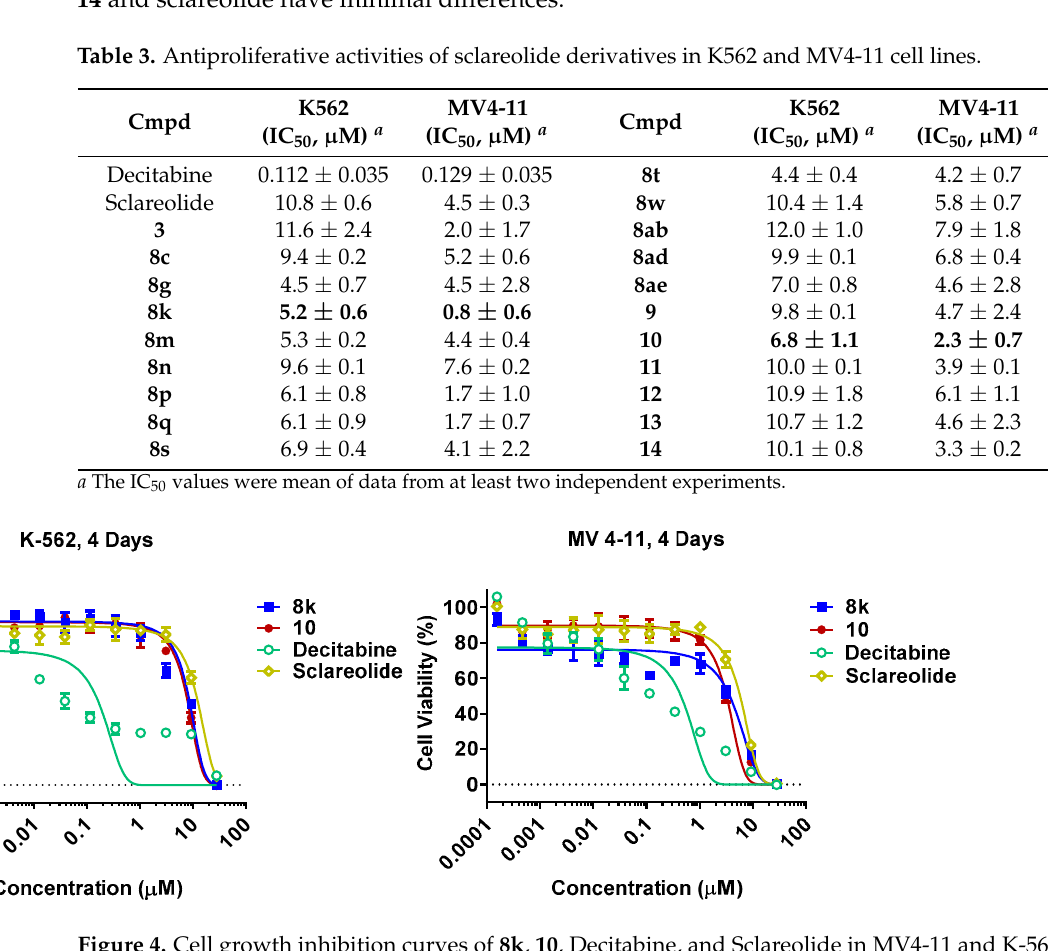
Figure 4. Cell growth inhibition curves of 8k , 10 , Decitabine, and Sclareolide in MV4-11 and K-562 cell lines upon 4-day treatment